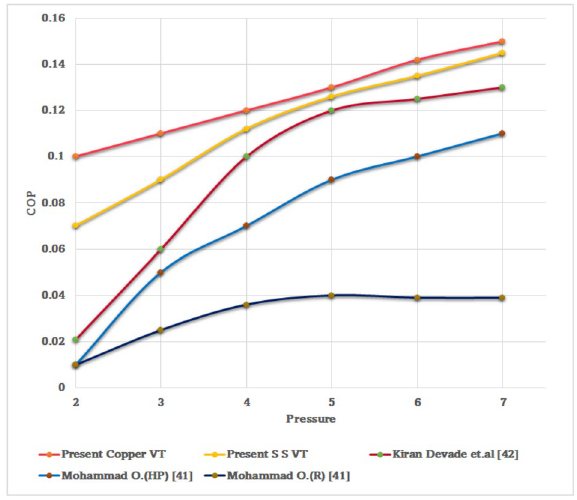
Figure 66. Pressure vs